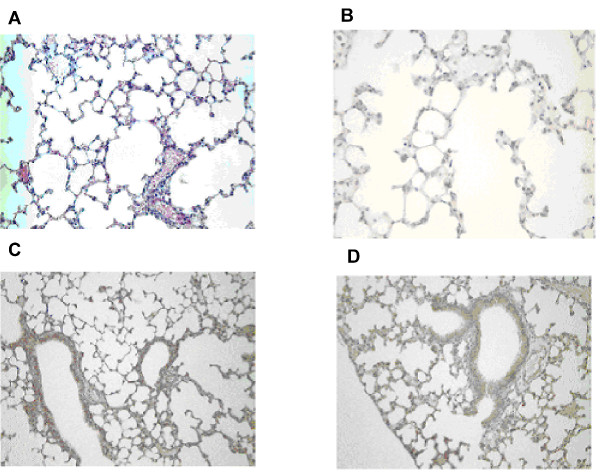
Absence of lung fibrosis in TGFβ1 overexpressing mice. Figure A shows haematoxylin and eosin staining of Tr+ TGFβ1 transgenic lung tissue. Of note was the absence of fibrosis in transgenic mice. To determine the molecular events underpinning this process we determined the expression of TGFβ1 (B), Type I receptor for TGFβ1 (C) and the TGFβ1 Type II receptor (D) by immunohistochemistry. As can be seen TGFβ1 and its receptors are present in abundance in lung tissue from these mice, indicating a normal TGFβ1 signalling cascade in Tr+ pulmonary tissue.